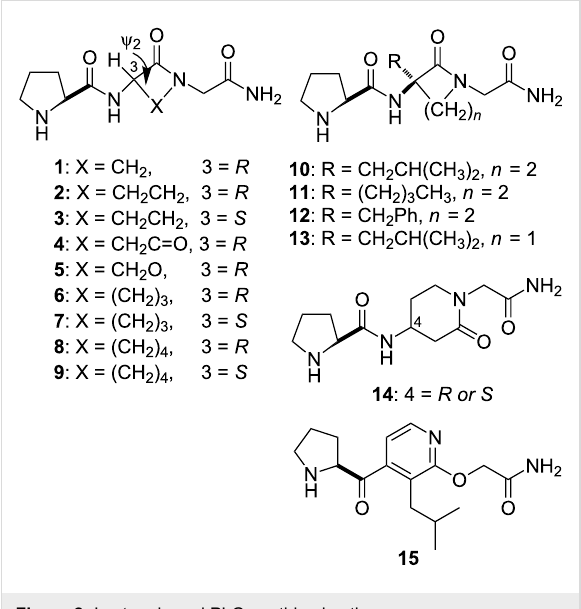
Figure 2: Lactam-based PLG peptidomimetics.